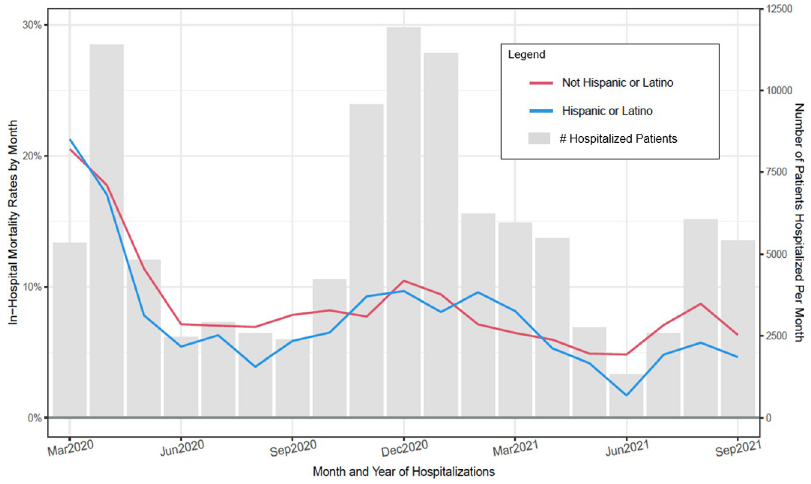
Fig 6. Observed in–hospital mortality rates (Deaths/hospitalizations) and number of patients hospitalized per month for patient ethnicity subpopulations (March 2020 through September